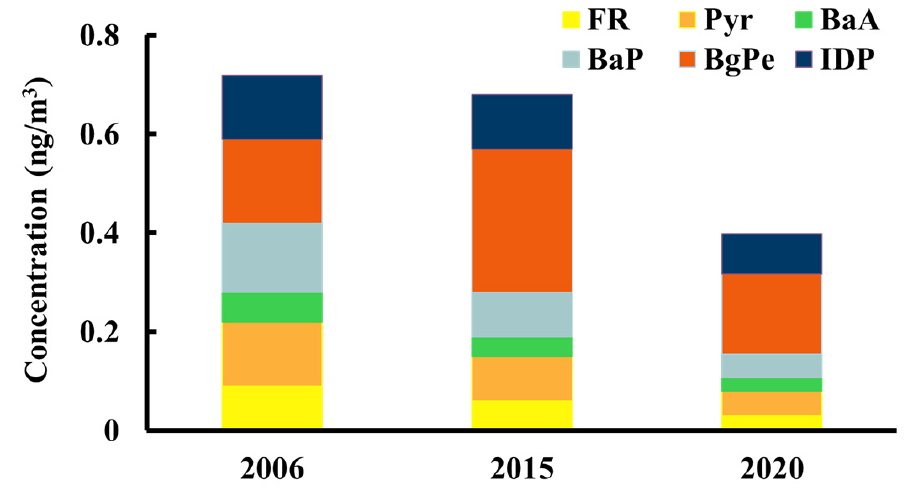
Figure 2. Concentration and composition changes of six PAHs in PM 2.5 in Singapore in 2006, 2015 and 2020.